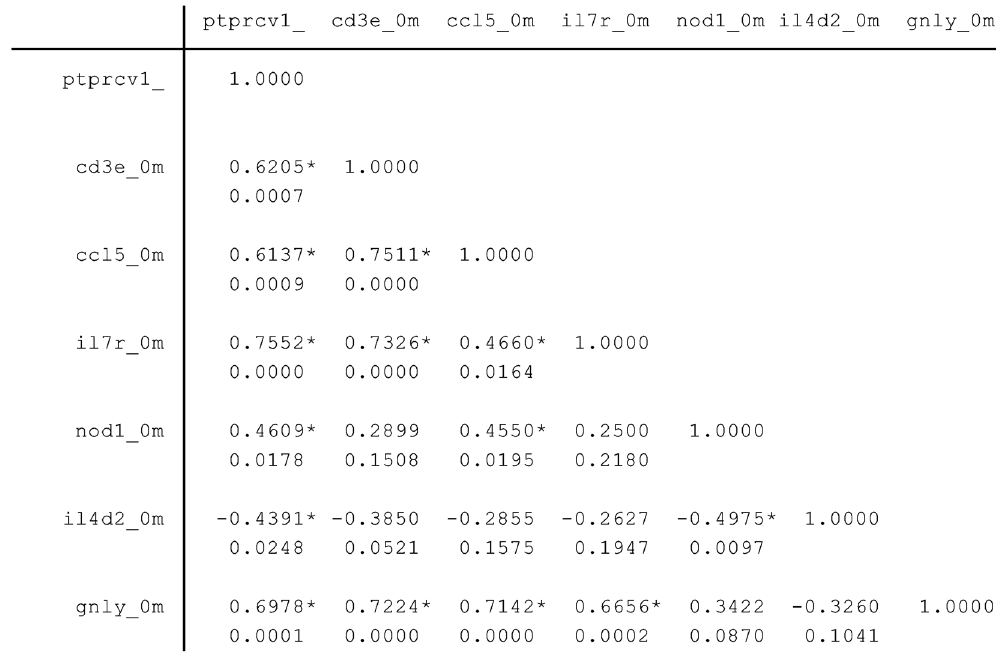
Figure 4. The relationship among the expression of genes. Spearman analysis was done to look the relationship among the expression of genes. Upper number indicates the degree of relation and lower number indicates P-value. – Sign indicates negative relation and * indicates had relation between the host gene